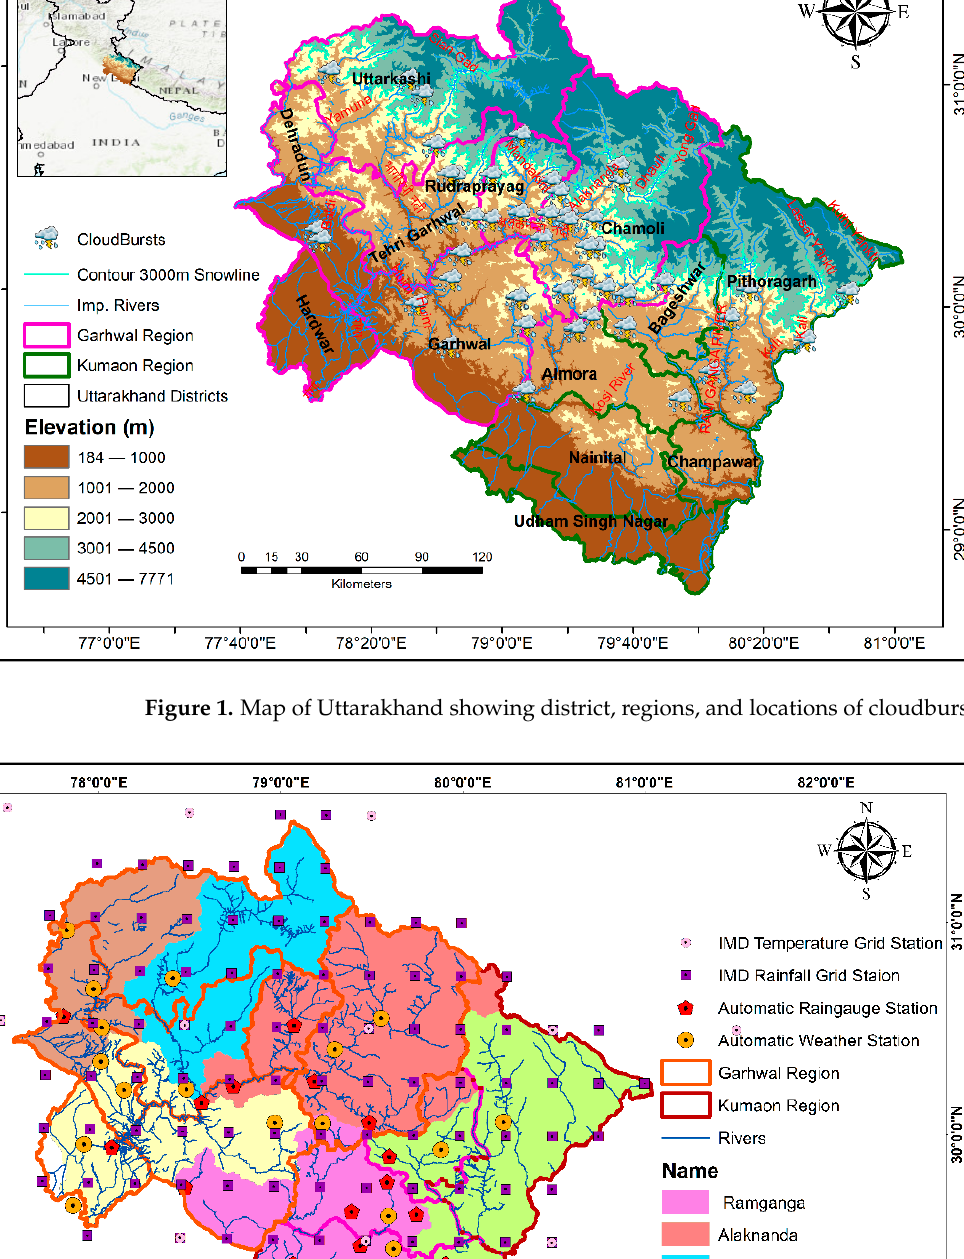
Figure 1. Map of Uttarakhand showing district, regions, and locations of cloudbursts.